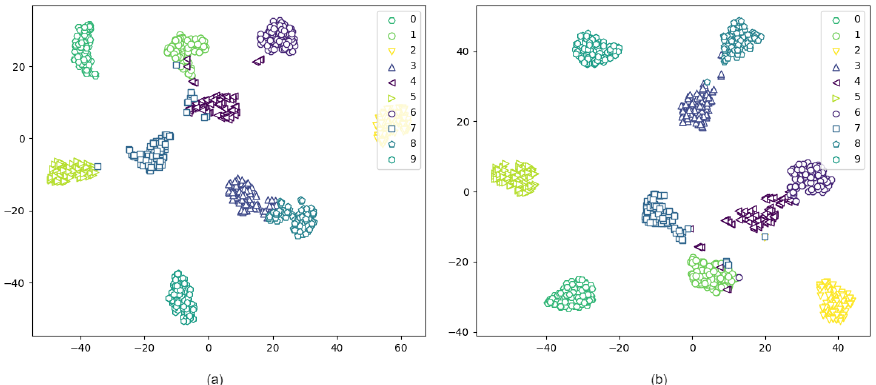
Figure 8. Features visualization via t-SNE for the proposed method on ( a ) 180 samples and ( b ) 120 samples. Table 4. Performance test results with 3000 training samples on CWRU.